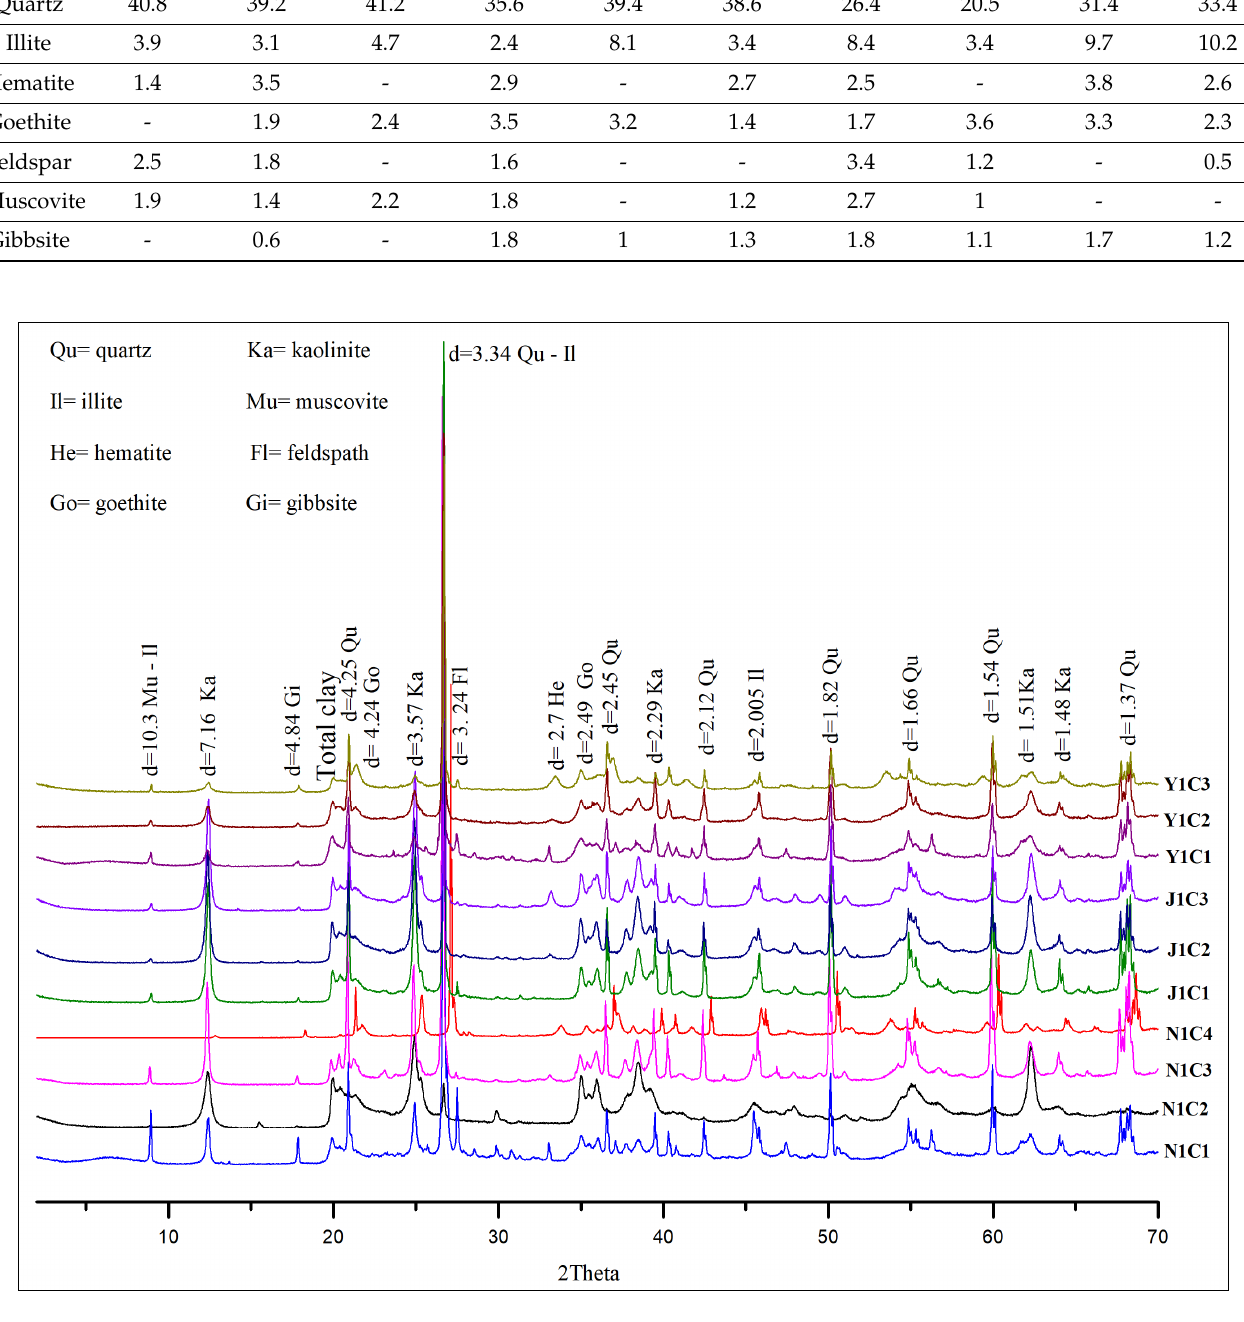
Figure 4. XRD patterns of raw clay materials of the eastern part of the Douala sub-basin.